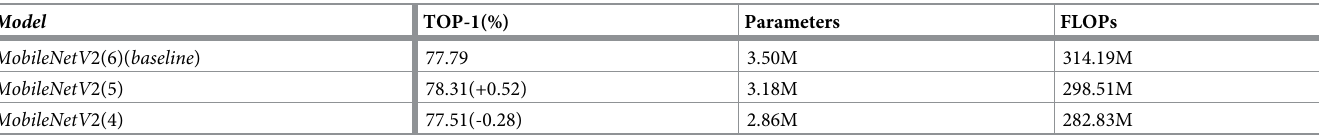
Table 2. Results on CIFAR-100.